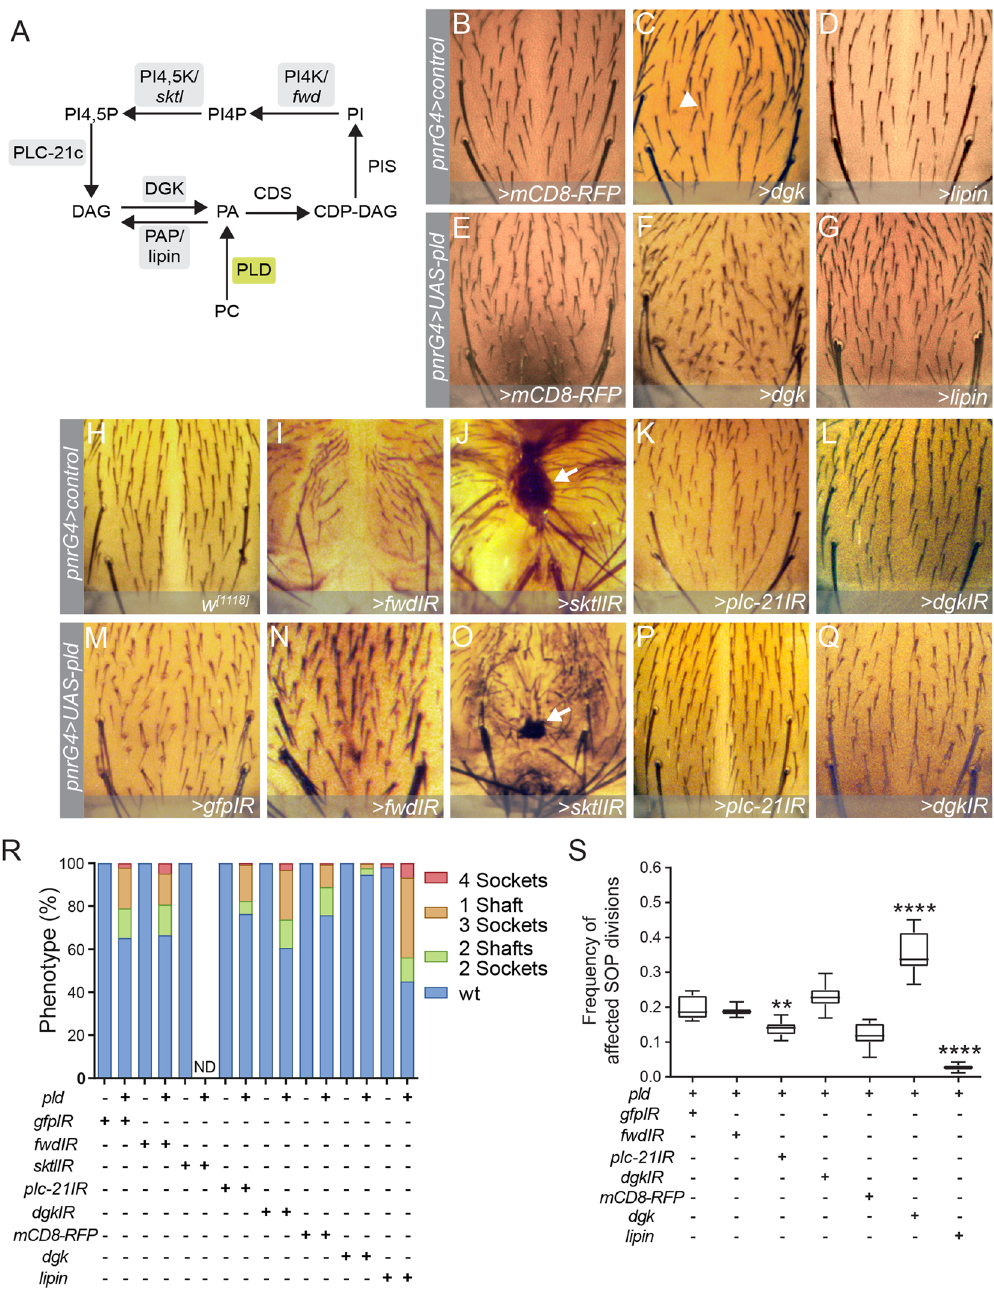
Figure 2. PLD-PA associated cell-fate defects are due to PA and not to PIPs or DAG accumulation. ( A ) Metabolic fates of PA. Gray boxes indicate the upregulated or downregulated enzyme. Green box indicates PLD. ( B – G ) Dorsal views of nota expressing UAS constructs targeting enzymes that control PA metabolism. Note that the overexpression of DGK in the central region of the notum directed by pnrGal4 (pnr > dgk ) results in the phenotype of 4 sockets, indicated by an arrowhead, in ~ 2% of the sensory organs analyzed, with 50% penetrance. ( H – Q ) Dorsal views of nota expressing UAS-RNAi (IR) constructs targeting enzymes that control PIPs and DAG metabolism. Note that the interference of the expression of these enzymes results in serious defects of the notum morphology, pnrG4 > fwdIR ( I ) pnrG4 > sktlIR ( J ) and pnrG4 > pld,sktlIR ( O ). The black scars associated with defective heminota fusion or migration ( J , O ) are indicated by arrows. Interestingly, these defects caused by reduced expression of fwd and sktl in the pupae, are partially rescued by the overexpression of PLD. ( R ) Distribution of the 4 phenotypes for each case. ( S ) Quantification of the frequency of SOP divisions affected by the gain function of Notch (n = 10, ND = not determined ** p < 0.01, **** p <